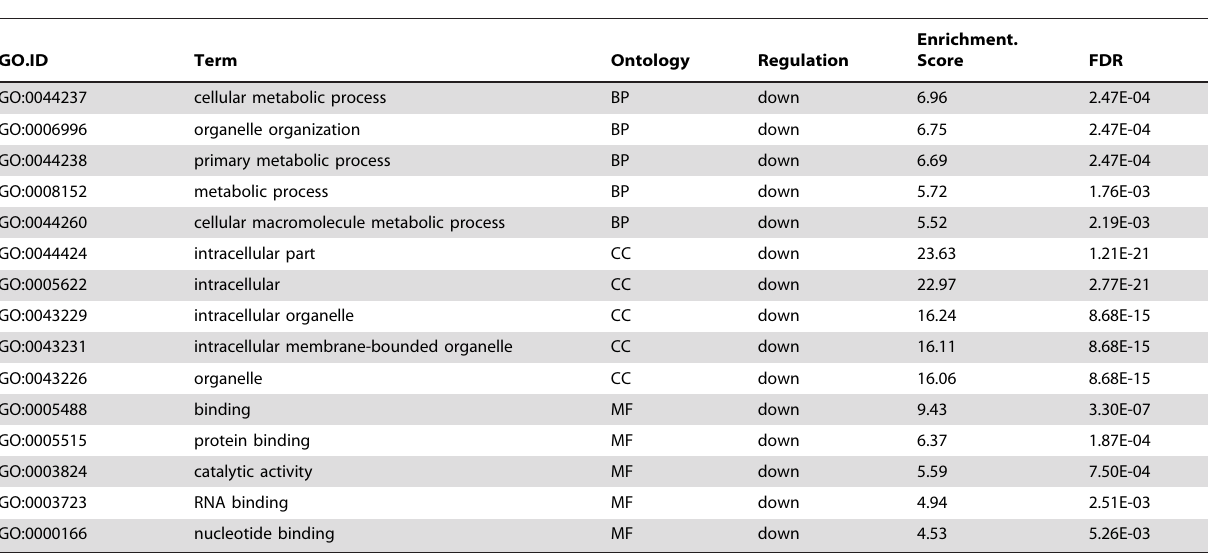
Table 5. Top 5 Enrichment GO term (BP, CC and MF) from the microarray data.